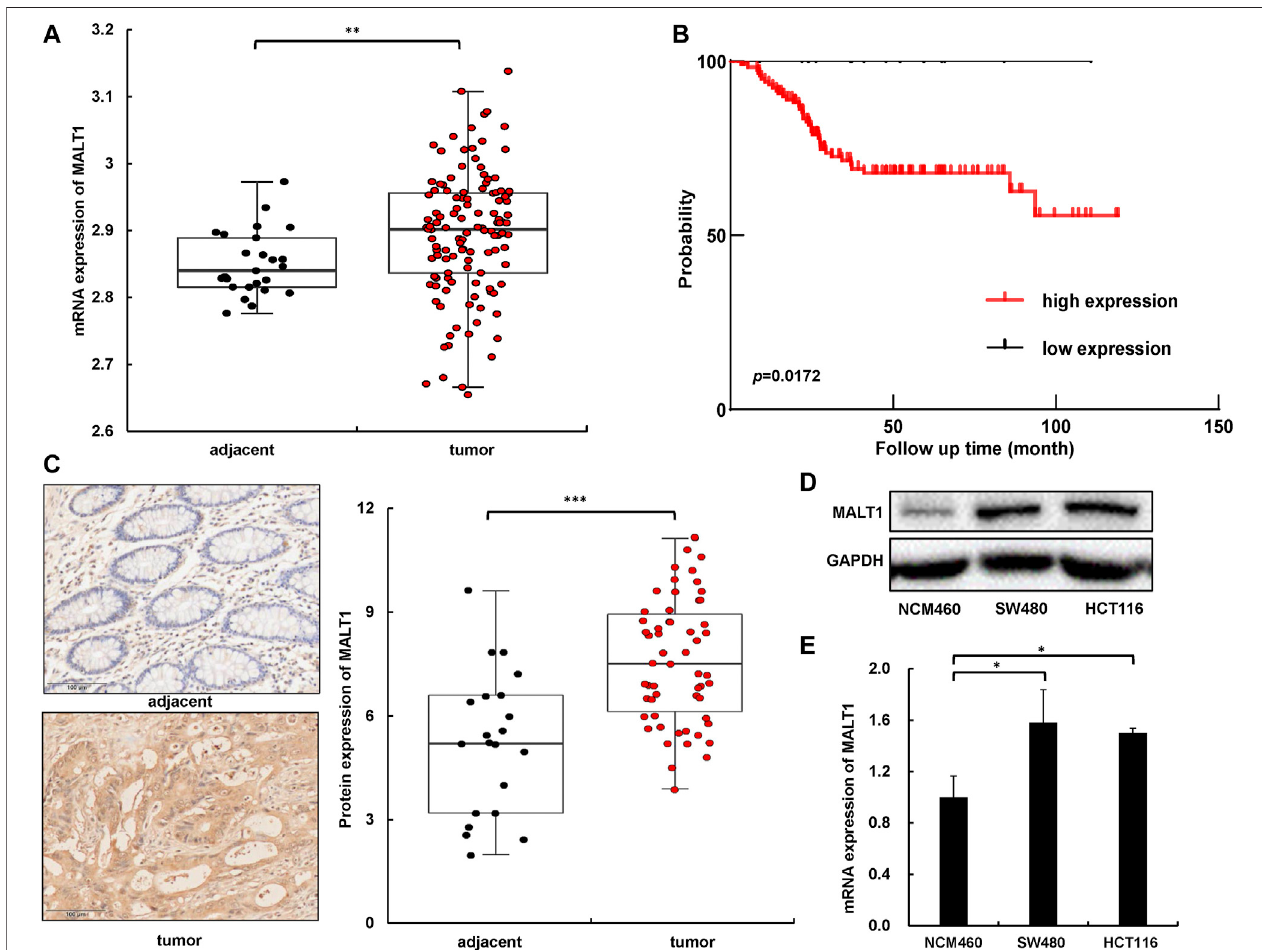
FIGURE 1 | MALT1 was highly expressed in CRC cells and tissues. (A) The mRNA level of MALT1 in colorectal tissues from CRC patients was higher than that in adjacent tissues. (B) Disease-free survival Kaplan – Meier curves of CRC patients based on expression of MALT1 level. p -values were calculated using log-rank test. (C) Representative IHC images of MALT1 in tissue specimens. Quanti fi cation of MALT1 levels according to IHC scores in adjacent and tumor tissue, respectively (right panel). (D) The protein level of MALT1 determined by immunoblotting. (E) The mRNA level of MALT1 determined by qPCR. Each experiment was performed in triplicate, and data are presented as mean ± SD. One-way ANOVA and Dunnett ’ s multiple comparison test were used to analyze the data (* p < 0.05, ** p < 0.01, *** p < 0.001).